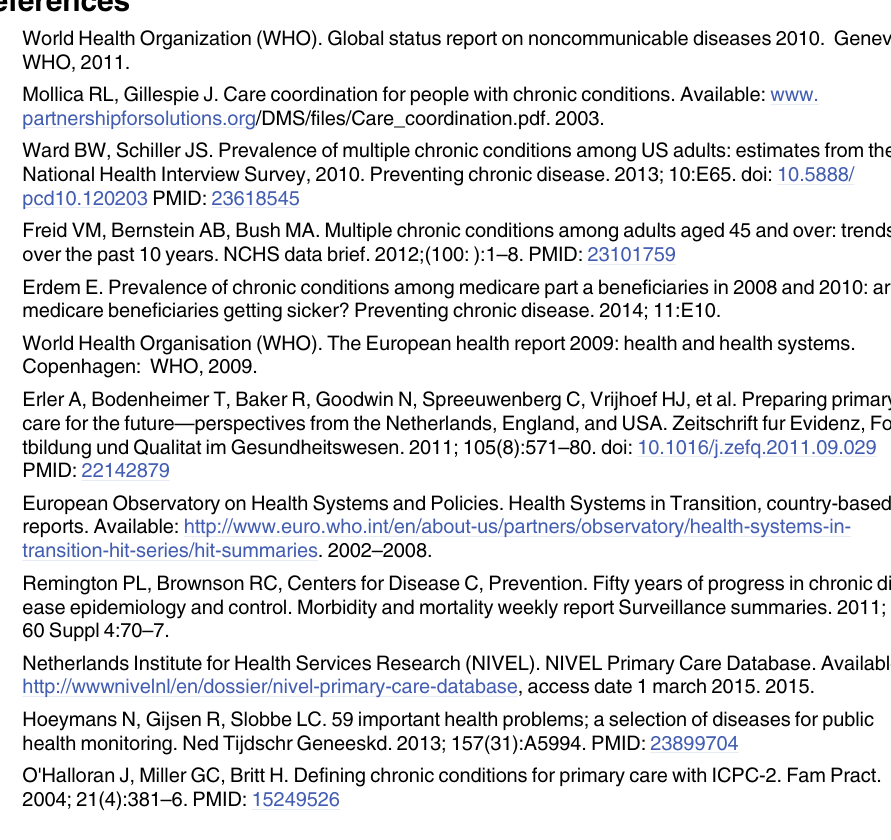
S1 Table. Selection of chronic diseases in the general practice registration (NIVEL Primary Care Database) (including ICPC codes). S2 Table. Selection of chronic diseases in the health surveys of Statistics